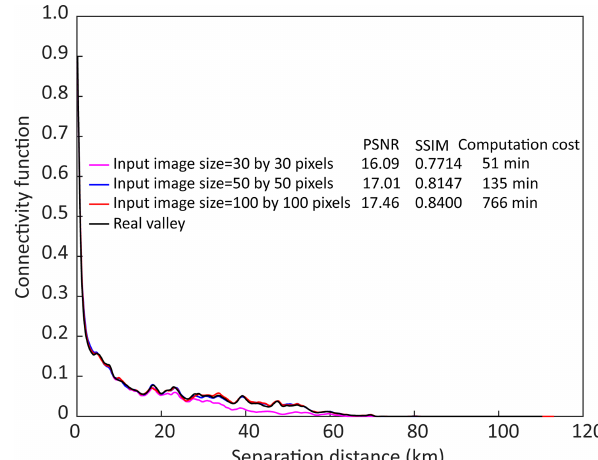
Figure A5. The connectivity function of the paleovalley generated by SRCNN, with the weight and bias values learned from the training images with sizes of 30, 50 and 100, respectively.